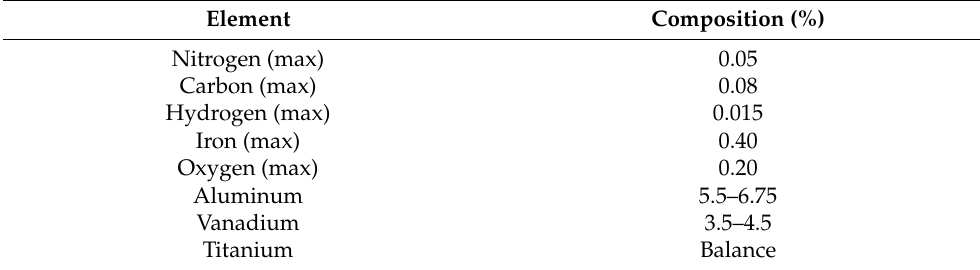
Table 1. Chemical compositions of the titanium alloy ASTM grade 5